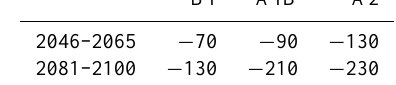
Table 1. Difference in mean annual temperature (in ◦ C) averaged over France of two future time slices under three emissions scenar- ios with respect to the 1961–1990 control run (adapted from Pag´e et al., 2008).